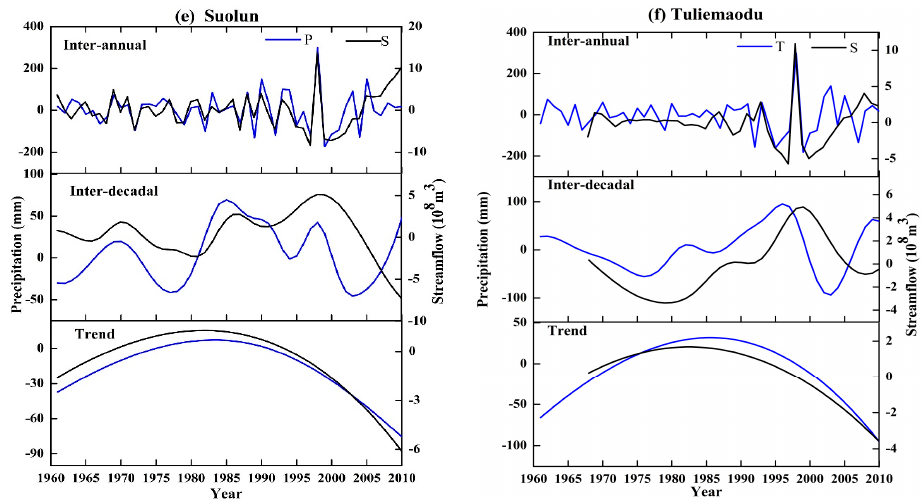
Figure 6. Nonlinear response of streamflow (S) at six gauge stations (( a ) Beian, ( b ) Shihuiyao, ( c ) Xiaoergou, ( d ) Zhalantun, ( e ) Suolun and ( f ) Tuliemaodu) to precipitation (P) during 1961–2010 in the headwater region of the Nenjiang River Basin, Northeast China.